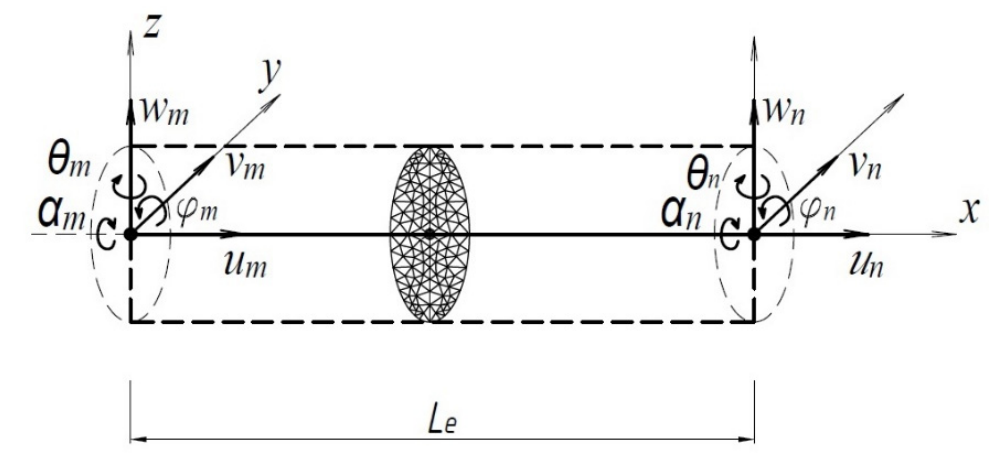
Figure 11. Combined finite element of a CFST column.